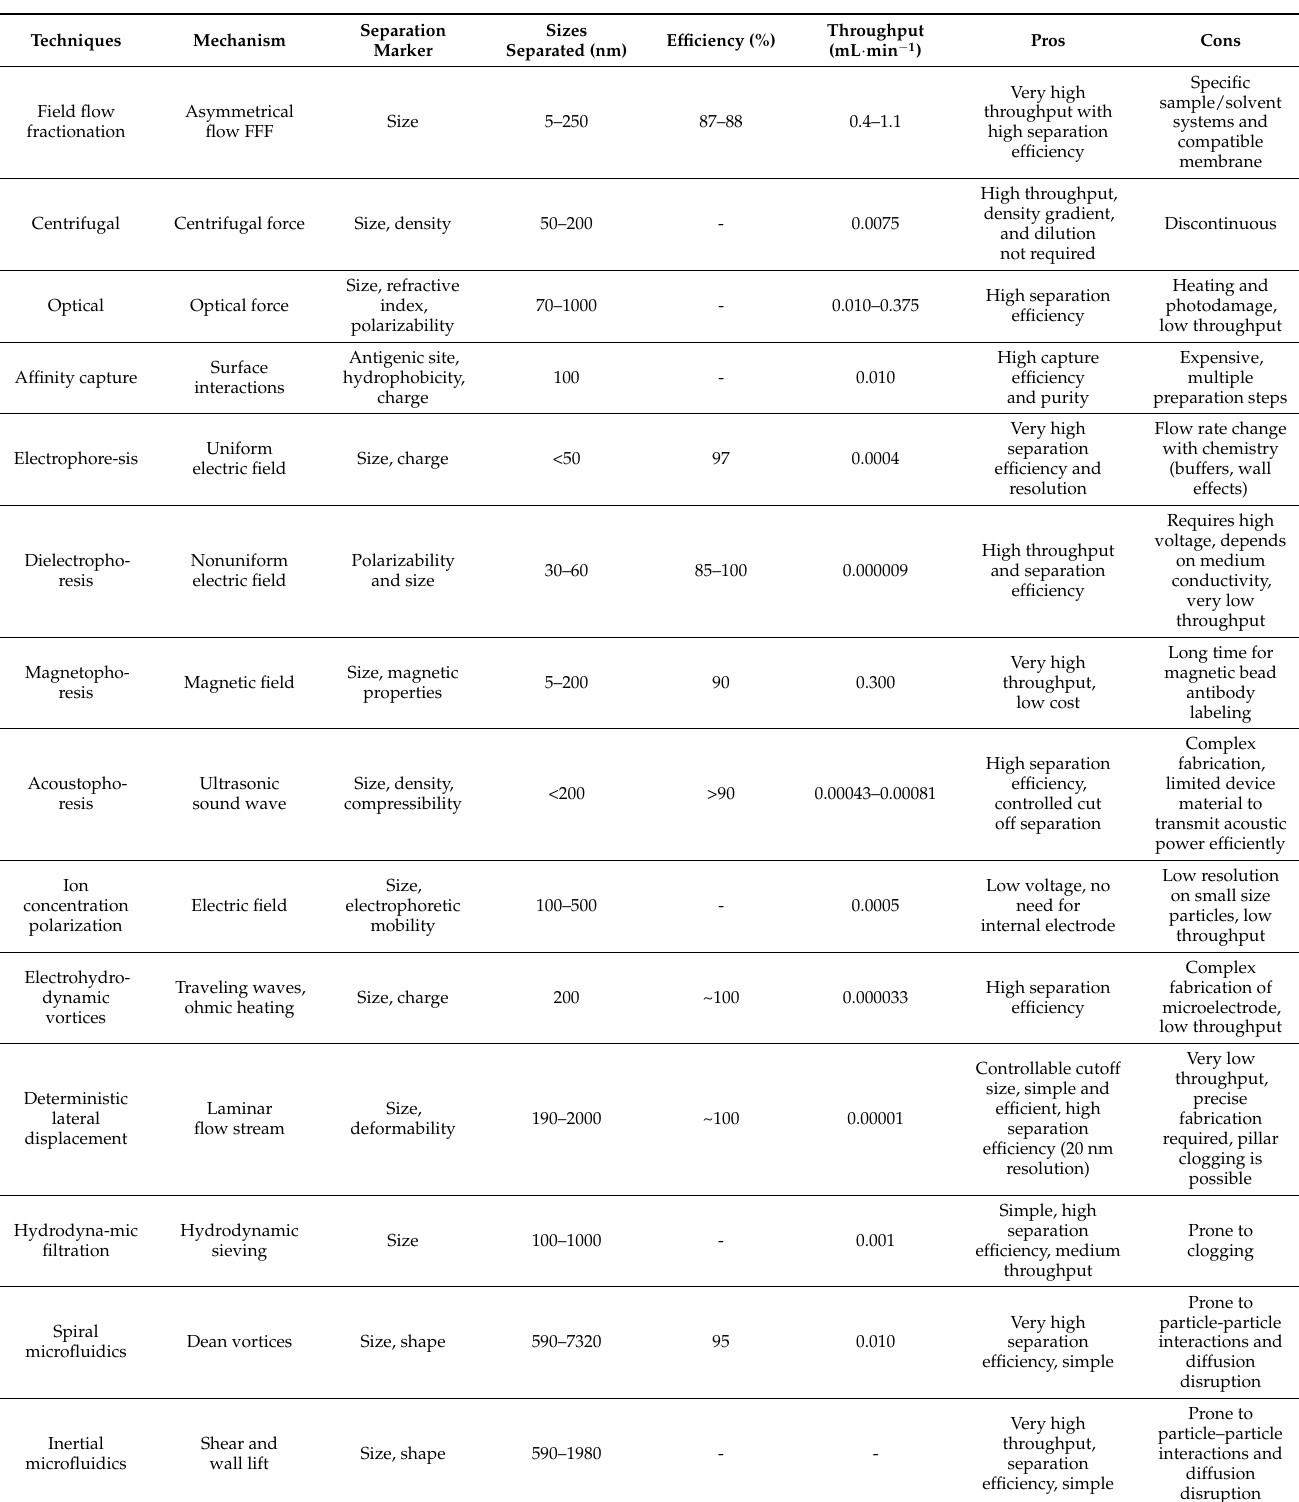
Table 4. Summary of microfluidic purification techniques for nanoparticles. Adapted with